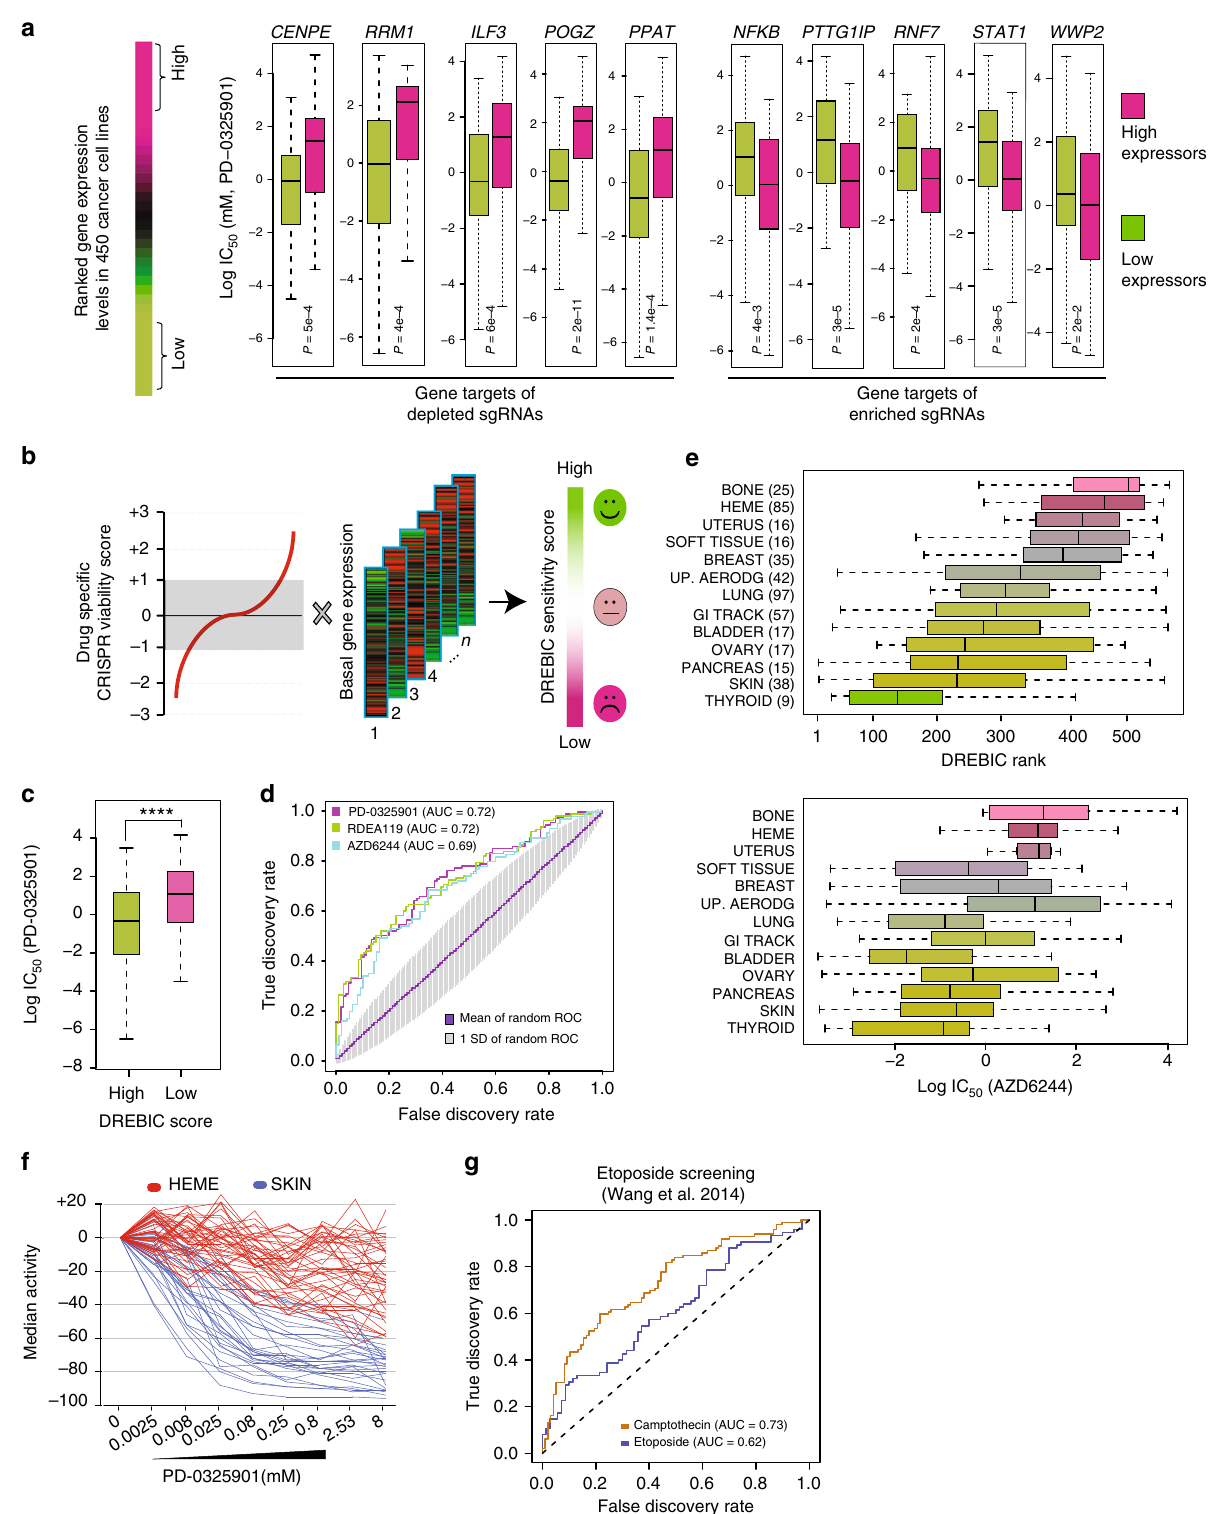
Software 1, Supplementary Data 2 – 3). Therefore, once the screening is performed for a given drug, the DREBIC approach can be used to calculate cell-type-speci fi c drug sensitivity scores as long as the gene expression pro fi le is available. We initially constructed cell-type-speci fi c DREBIC scores based on CRISPR viability scores of all genes in the screen. To